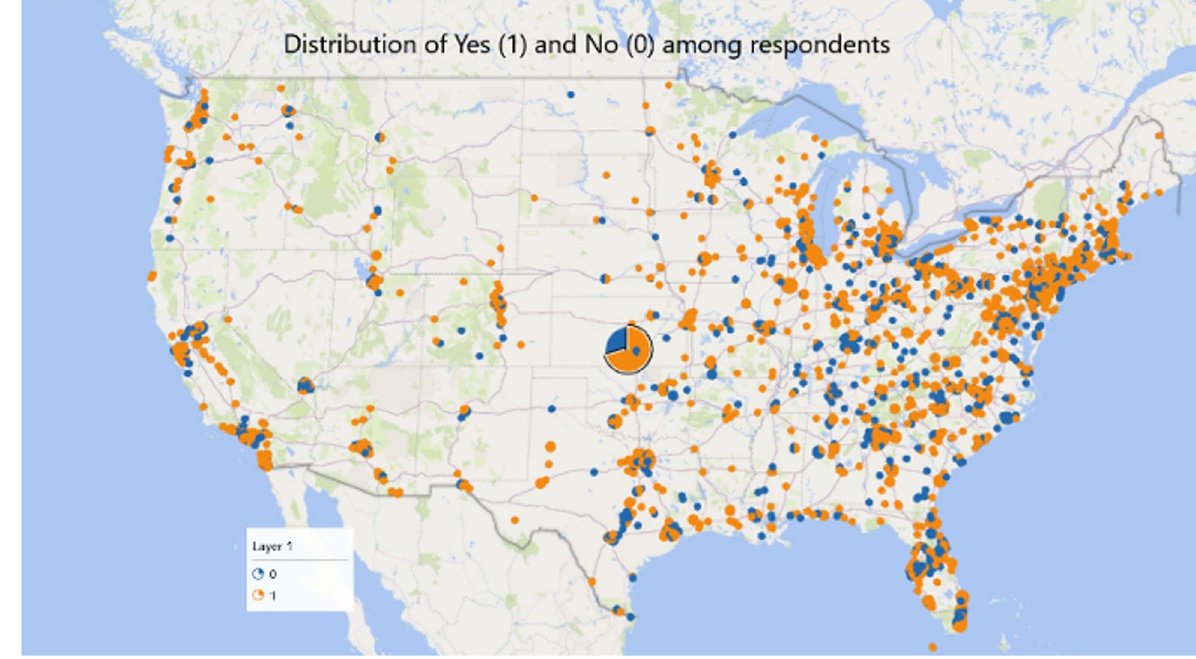
Fig. 3 Location of Yes/No among respondents.